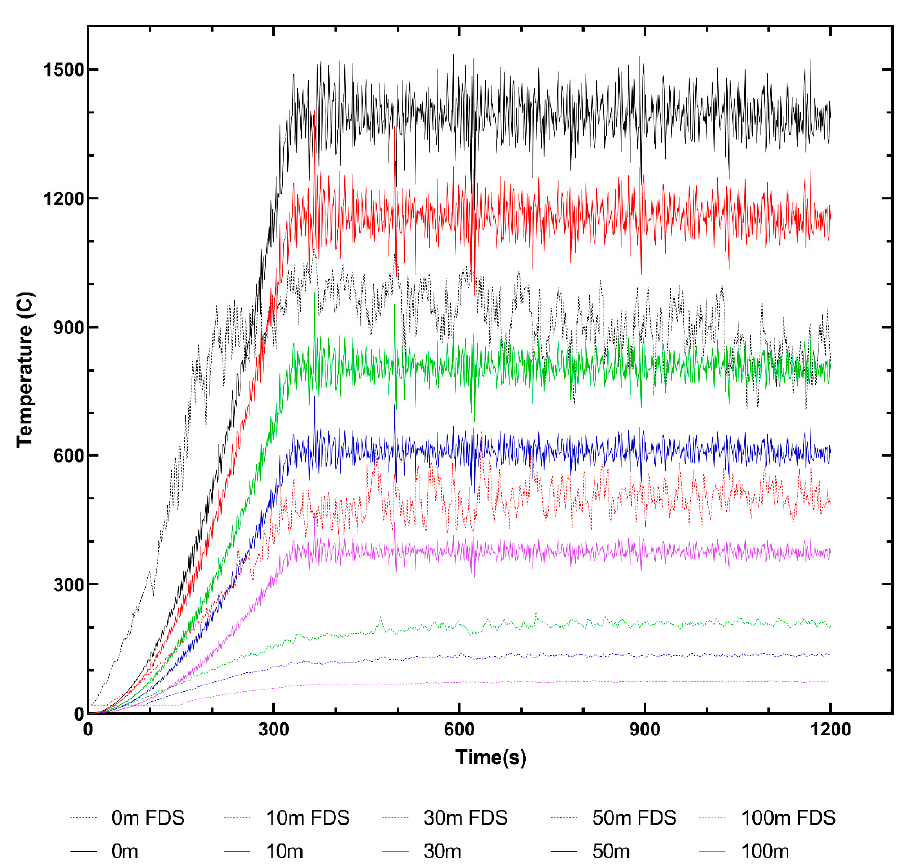
Figure 2. Comparison of the tunnel ceiling gas temperatures calculated with the empirical model with the values extracted by the numerical simulation at different distances above the fire source.